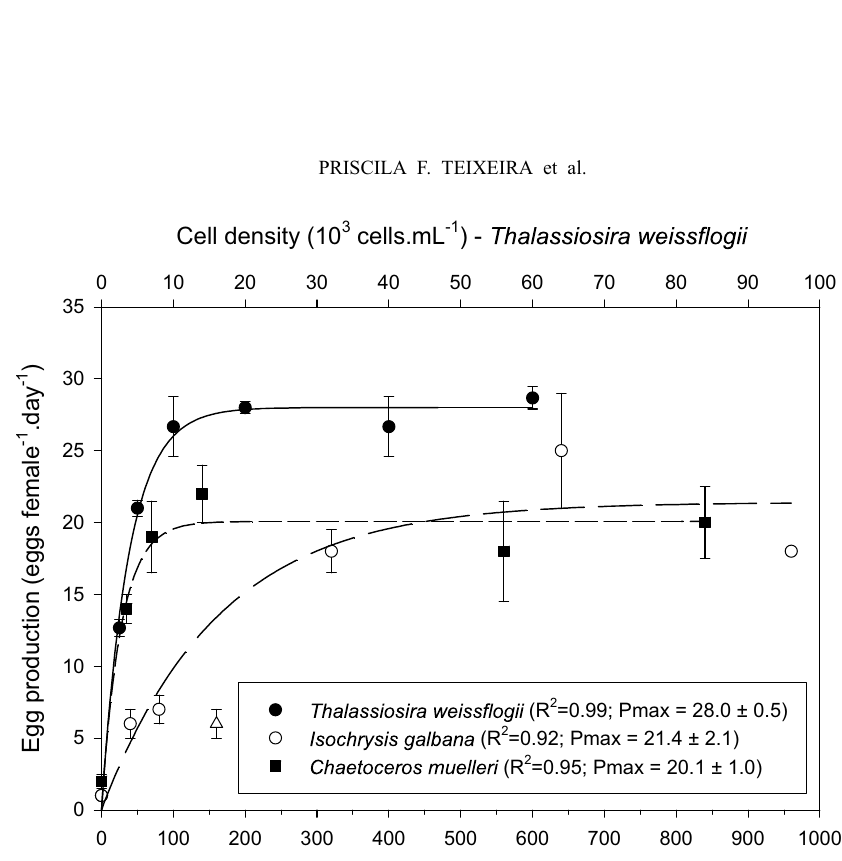
Fig. 1 – Egg production in the copepod Acartia tonsa using three different food sources: the microalgae Thalassiosira weissflogii (closed circles; solid line; top x axis), Chaetoceros muelleri (closed squares; short dashed line; bottom x axis) and Isochrysis galbana (open circles; long dashed line; bottom x axis). Different cell densities were tested for each microalgae species to give an equivalent biovolume value at each experimental condition. Copepods were acclimated to fixed salinity (30), temperature (20 ◦ C) and photoperiod (12L:12D) before tests. Tests were performed under the same acclimation conditions. Results are expressed as mean ± standard error. Data were analyzed by non-linear regression analysis (exponential with saturation). Pm = maximum egg production expressed as eggs.female − 1 .day − 1 . R 2 = regression coefficient. Egg production data with I. galbana at 160 . 10 3 cells.mL − 1 (open triangle) was considered as an